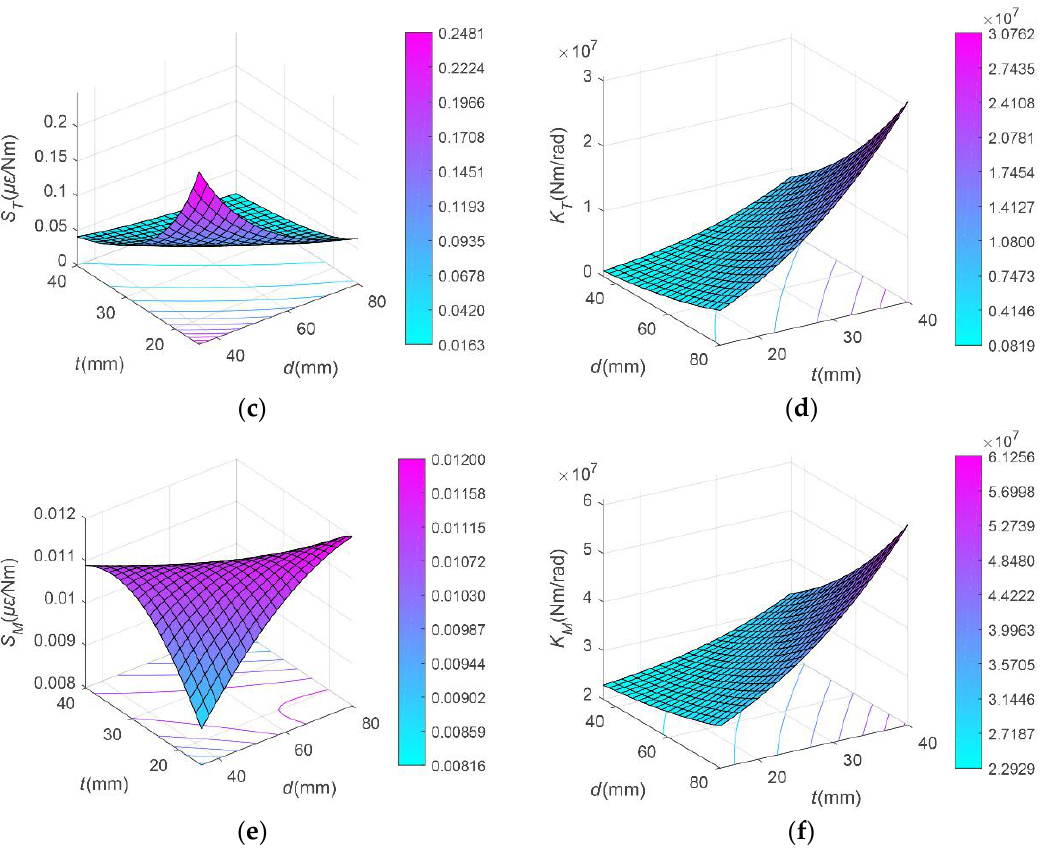
Figure 4. Relationships among d , t , and sensitivities and stiffnesses: ( a ) S P ; ( b ) K P ; ( c ) S T ; ( d ) K T ; ( e ) S M ; ( f ) K M .